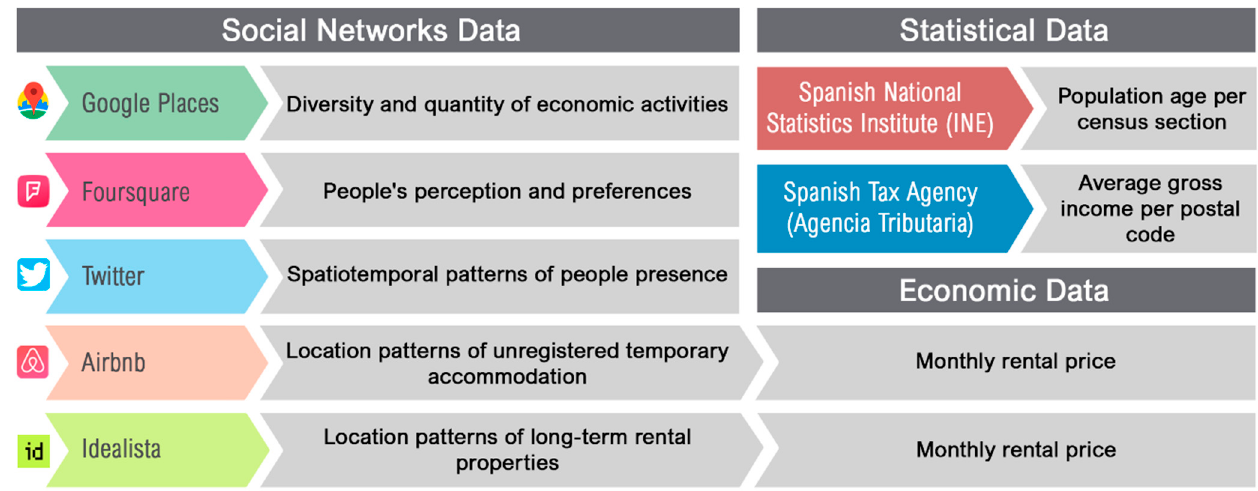
Figure 2. Data sources used for the study.